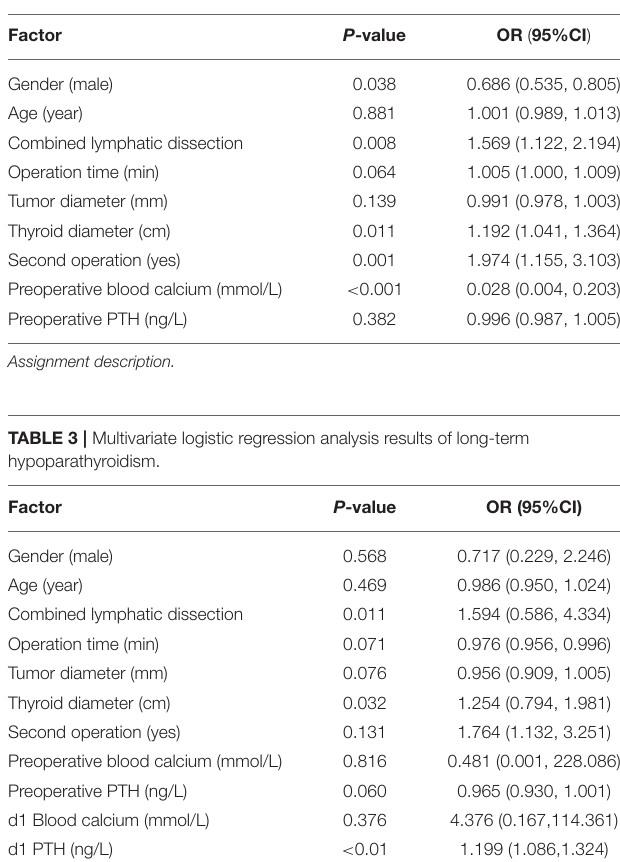
TABLE 2 | Multivariate logistic regression analysis results of transient hypoparathyroidism.